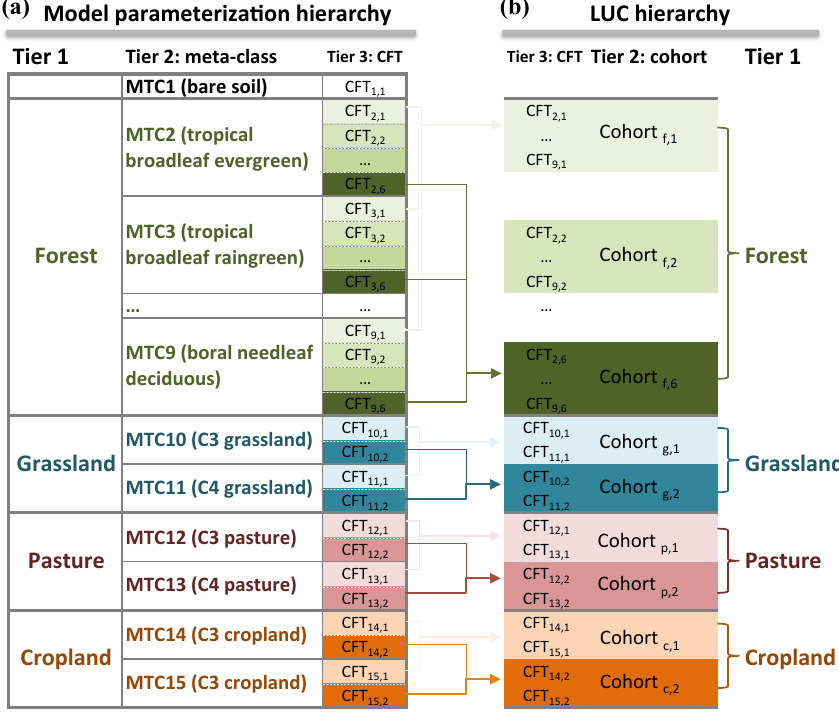
Figure 3. Two parallel hierarchies from the model parameterization and land use change perspective. (a) Sub-grid cohort function types (CFTs) as inheritances of meta-classes (MTCs) and the corresponding parameterization hierarchy. There are in total 14 vegetative MTCs corresponding to four vegetation types. The notation of CFT i,j indicates that it inherits from MTC i and belongs to the j th cohort (Cohort j ). Each forest MTC has six cohorts, with Cohort 1 being the youngest and Cohort 6 the oldest, whereas each herbaceous MTC is set tentatively to have two cohorts. Darker colours indicate older cohorts. (b) Within the gross LUC module hierarchy, Tier 3 remains the level of CFT, but CFTs are reorganized to derive the Tier 2 information based on the level of cohorts under the same Tier 1 as in (a) . A cohort baring the notation of Cohort v ,i indicates it belongs to vegetation type “v” (where “v” could be forest, natural grassland, pasture, or cropland) and meta-class “ i ”. This reorganization of the hierarchy from the left to the right side is to prepare for properly allocating prescribed LUC transitions first onto the cohort level, then further to different CFTs within each